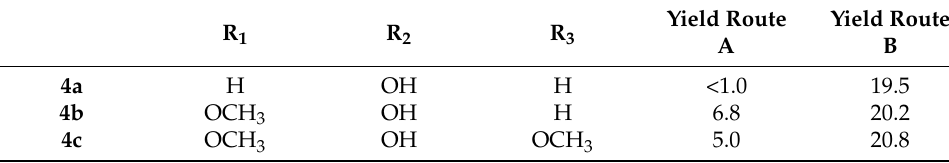
Table 1. Yields of different pyridine curcuminoid 4a ‐ c.